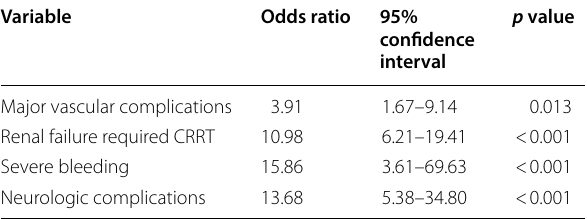
Table 4 Predisposing factors for in-hospital mortality (multivariate logistic